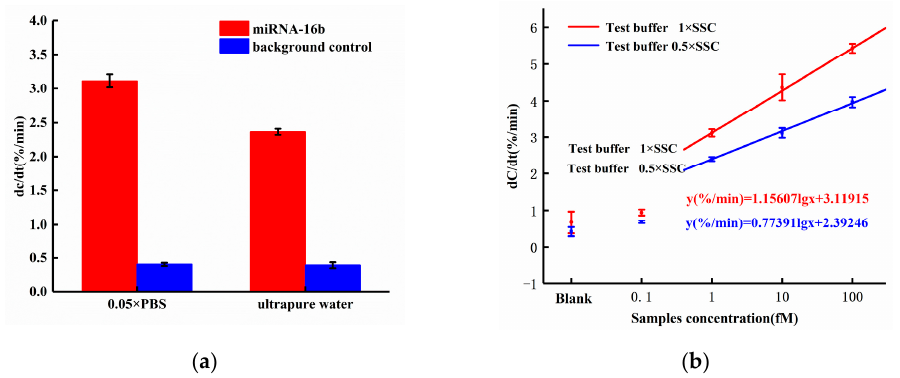
Figure 6. ( a ) Sensor response with probe diluting in 0.05× PBS and ultrapure water; ( b ) Dose re ‐ sponses with miRNA ‐ 16b diluting in 0.5× SSC and 1× SSC.